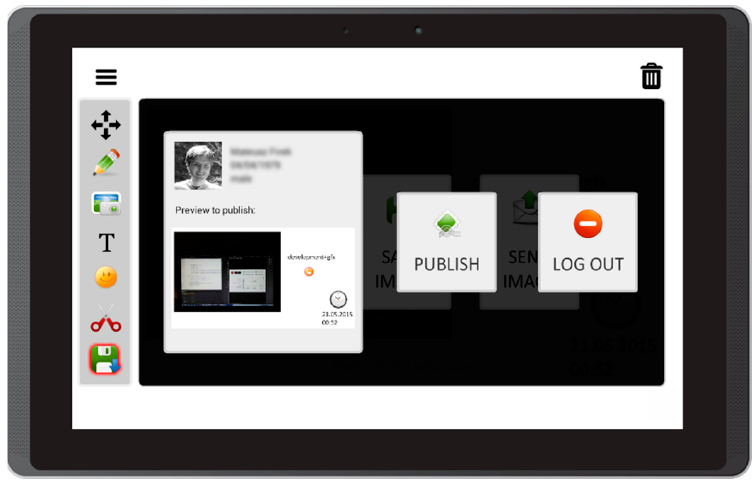
Figure 10. Publishing a canvas to Facebook with an easy-to-use interface and sending emails in Aphasia Create (screenshot from an Android tablet).